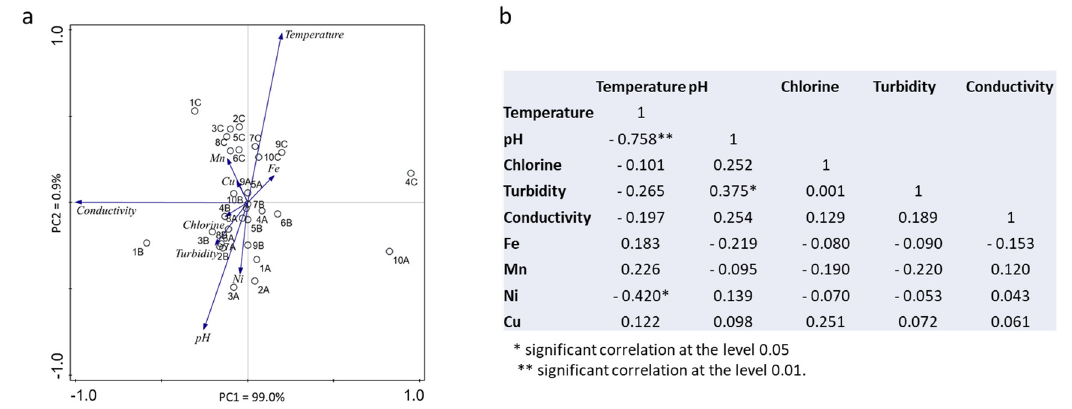
Figure 3. Principal Components analysis (PCA) ( a ) and Pearson correlation coefficients ( b ) deter- mined for the physical-chemical parameters.